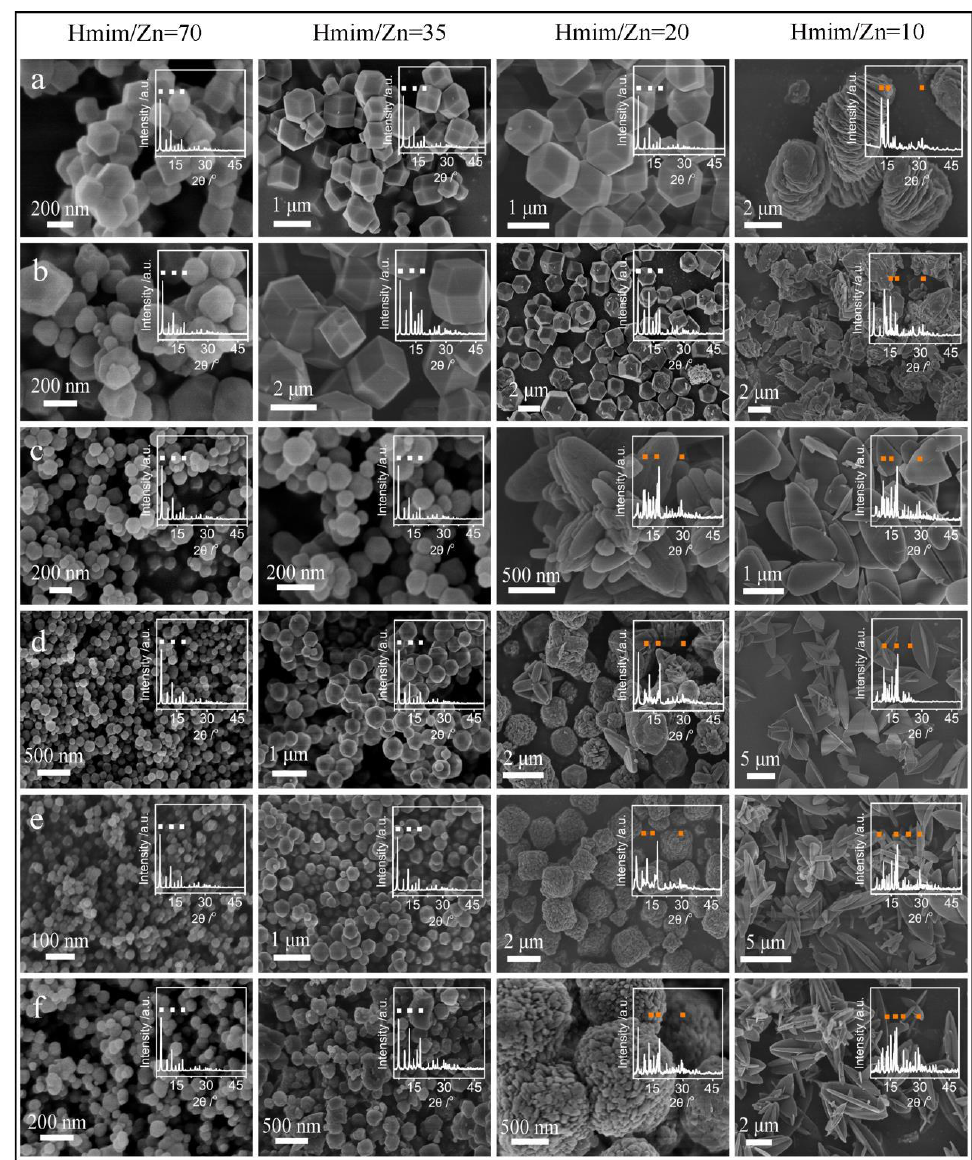
Figure 1. PXRD (powder X-ray diffraction) patterns and SEM (scanning electron microscopy) images (inserted) of the products provided from various ratios of Mim/Zn, beginning with ( a ) Zn(OAc) 2 , ( b ) ZnSO 4 , ( c ) Zn(NO 3 ) 2 , ( d ) ZnCl 2 , ( e ) ZnBr 2 , and ( f ) ZnI 2 [74].